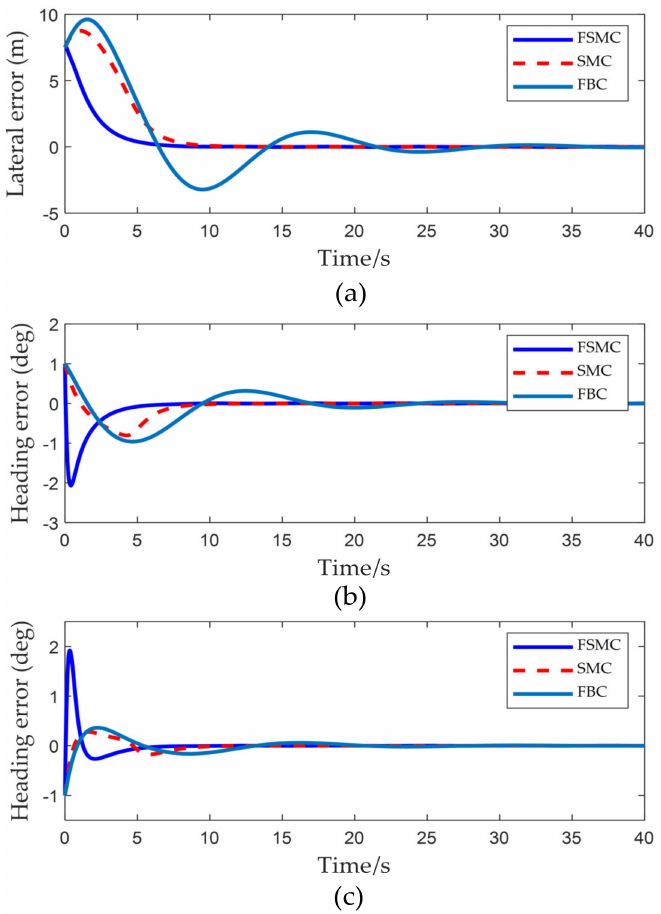
Figure 5. The vehicle states of the tractor-trailer: ( a ) the position error; ( b ) the heading error; ( c ) the articulated angle; ( d ) the sliding